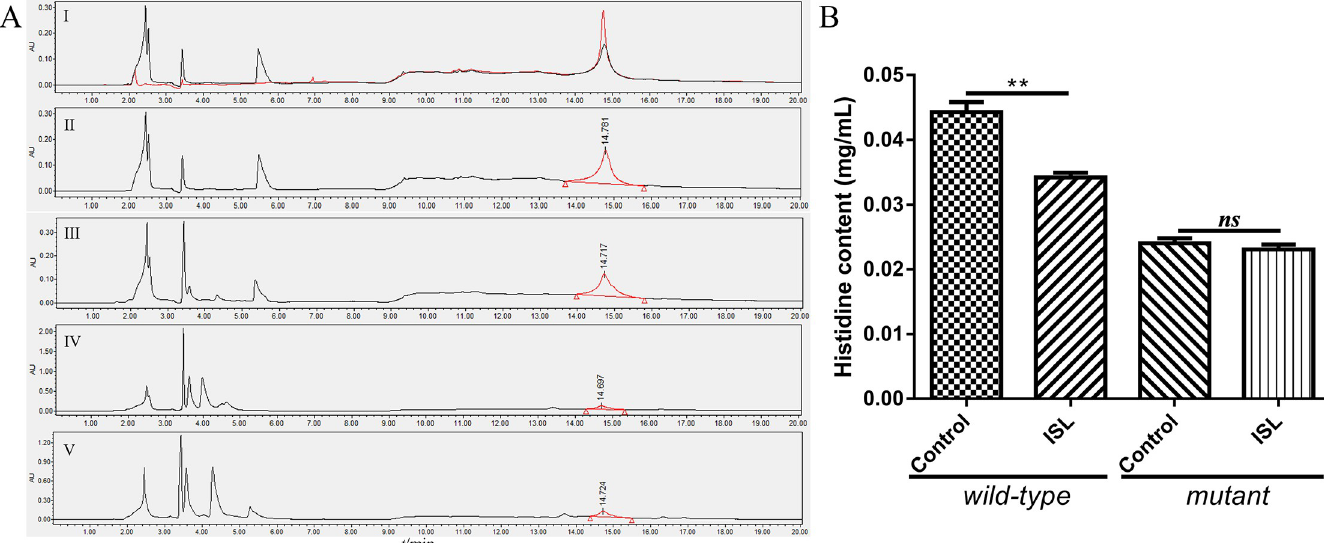
Fig 5. Determination of S . xylosus histidine content. (A) The HPLC chromatograms of bacterial extract and histidine standard solution. I) The HPLC chromatograms of bacterial extract (black, retention time 14.781 min) and histidine standard solution (red, retention time 14.753 min). III and V) S . xylosus (wild-type strain or mutant strain) grown in the presence of 1/2 MIC of ISL. II and IV) Untreated wild-type strain and mutant strain served as a control. (B) Peak area analysis of S . xylosus histidine content by HPLC. S . xylosus (wild-type strain or mutant strain) grown in the presence of 1/2 MIC of ISL. Untreated wild-type strain and mutant strain were used as control. Data are expressed as means ± SDs. Significant difference compared to the untreated control group are represented with asterisk ( � ) ( � p < 0.05, �� p < 0.01, and ��� p <